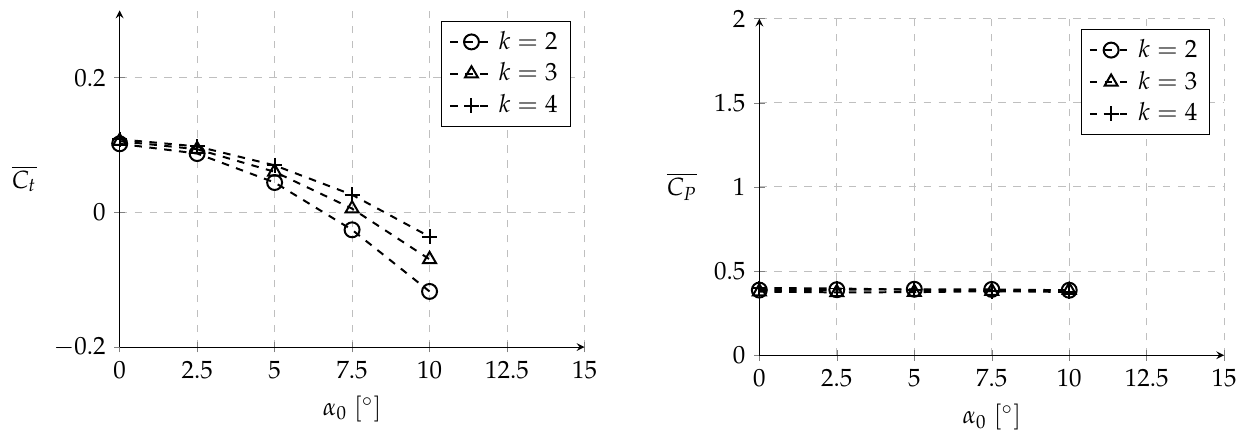
Figure 10. Mean thrust and power coefficients as a function of α 0 at St = 0.15.